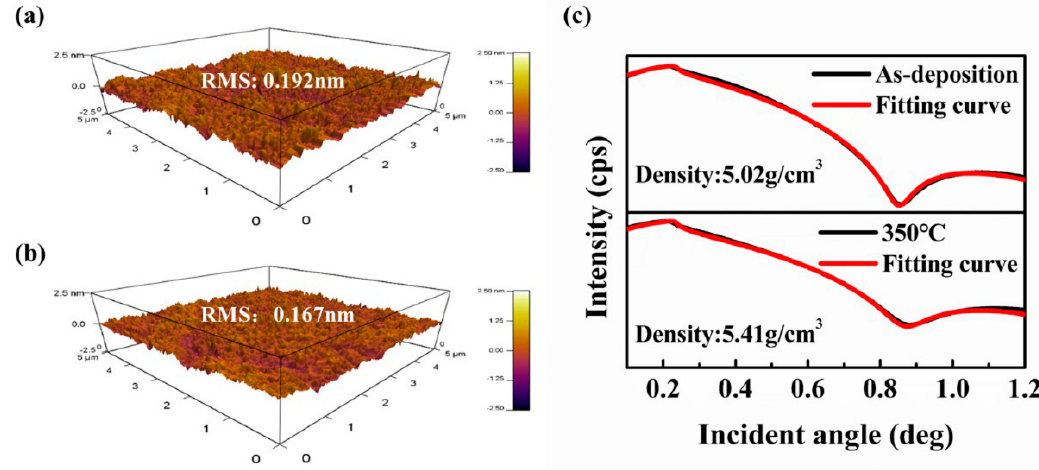
Figure 3. AFM images (5 × 5 μ m) of 5 nm a-STO films: ( a ) as-deposition and ( b ) 350 °C. ( c ) The XRR curves of 5 nm a-STO films.